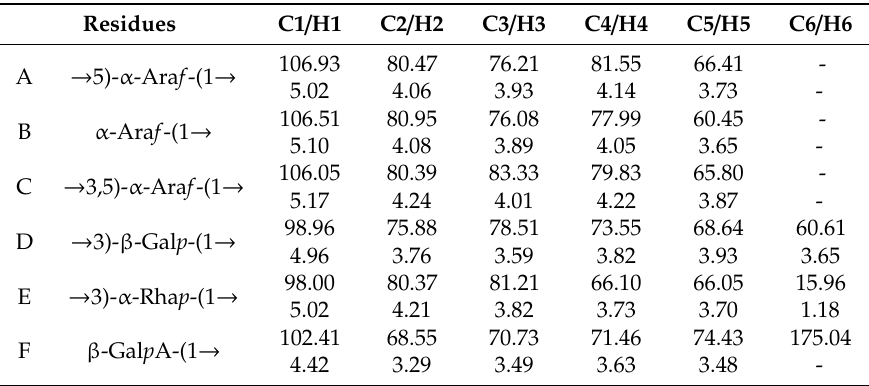
Table 2. NMR signal assignment of